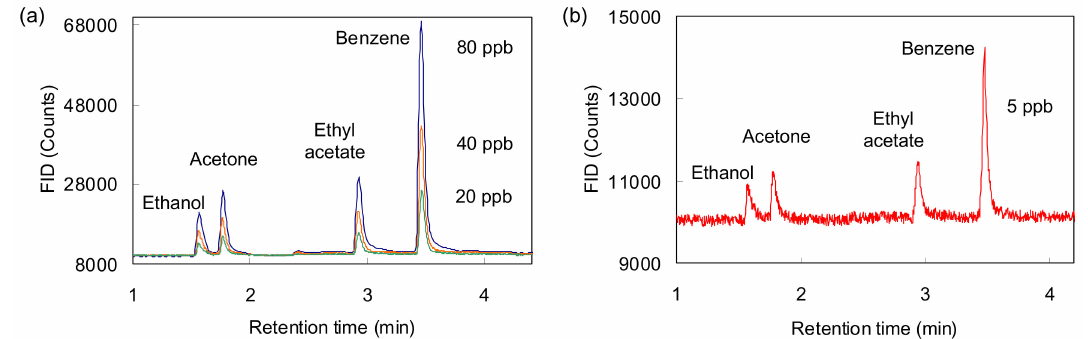
Figure 7. µ -Preconcentrator/GC-FID chromatograms of the four target compounds at various concentrations using a 1 L air sample volume. ( a ) Chromatograms of 20, 40, and 80 ppb concentrations. ( b ) Chromatogram of a 5 ppb concentration. The sampling flow rate was 40